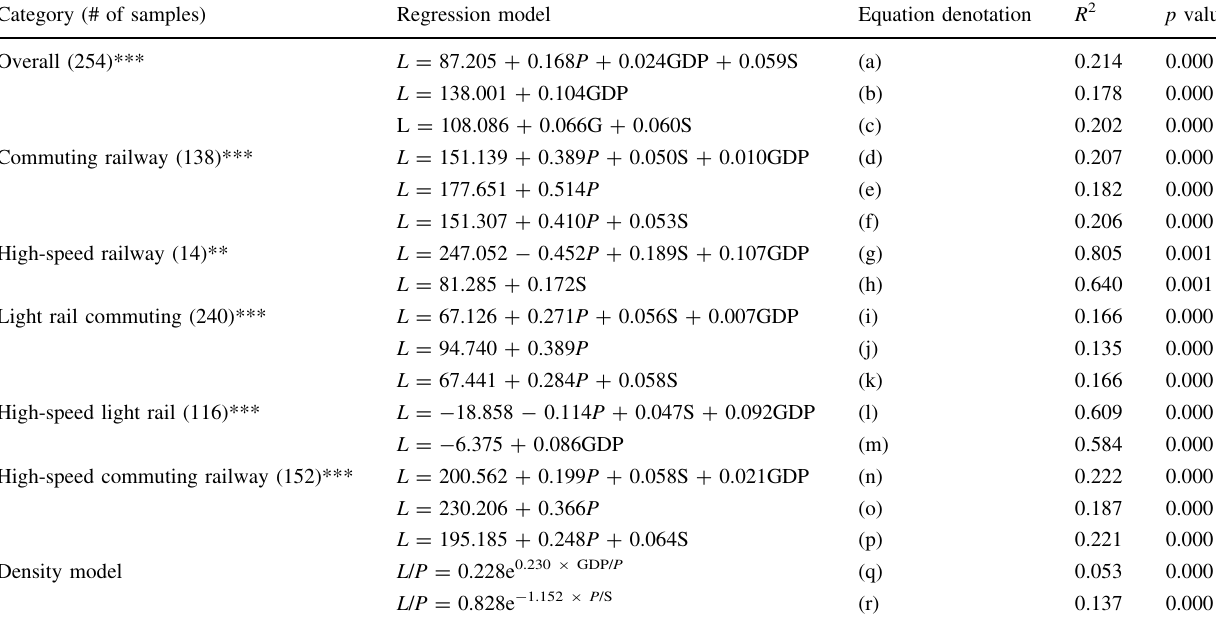
Table 1 Regression models for rail transit length and social economic factors Category (# of samples)